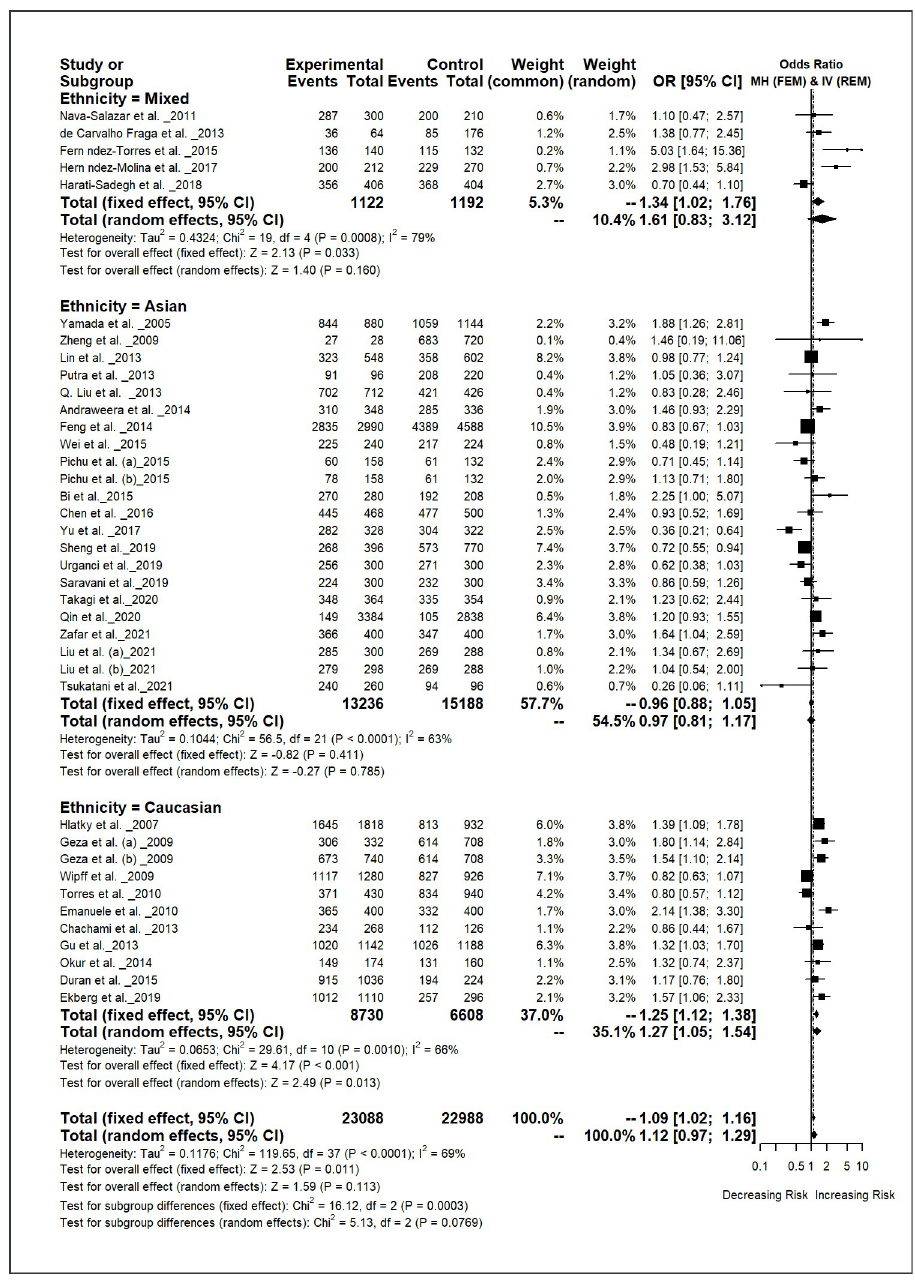
Fig 2. Forest plot of HIF1A 1772 C/T polymorphism and overall disease risk for different ethnic populations under allelic model [ C vs. T ]. In the forest plot, the square of the horizontal line represents the individual study- specific odds ratios (ORs) with 95% confidence intervals (CIs) and the black area of the squares represents the corresponding study weight. The black diamond reflects the pooled OR and the lateral points of the diamond represent the CI of the overall analyses. The solid vertical lines are the OR of 1 indicates no effect. The dashed vertical line shows the corresponding pooled OR of the analyses.